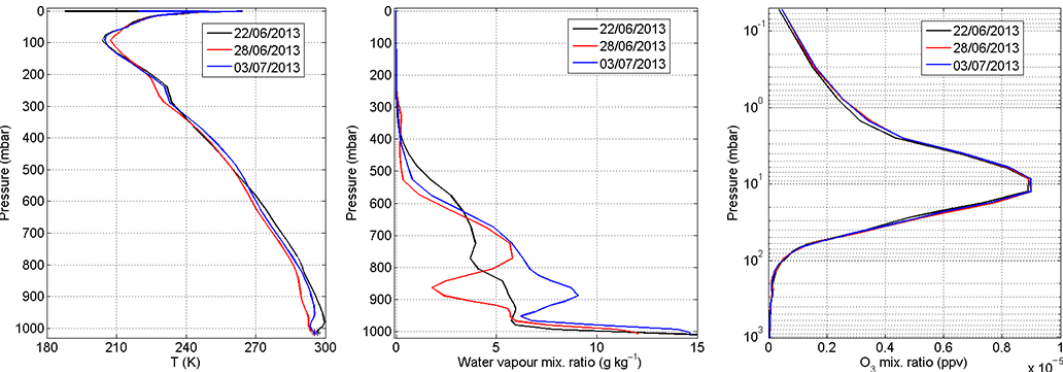
Figure 3. From left to right: ECMWF spatial–temporal average profiles for temperature (left), water vapour (middle), and ozone (right) on the days involved in this analysis. Together with the temperature profiles, ECMWF average surface temperatures for each day are also indicated by